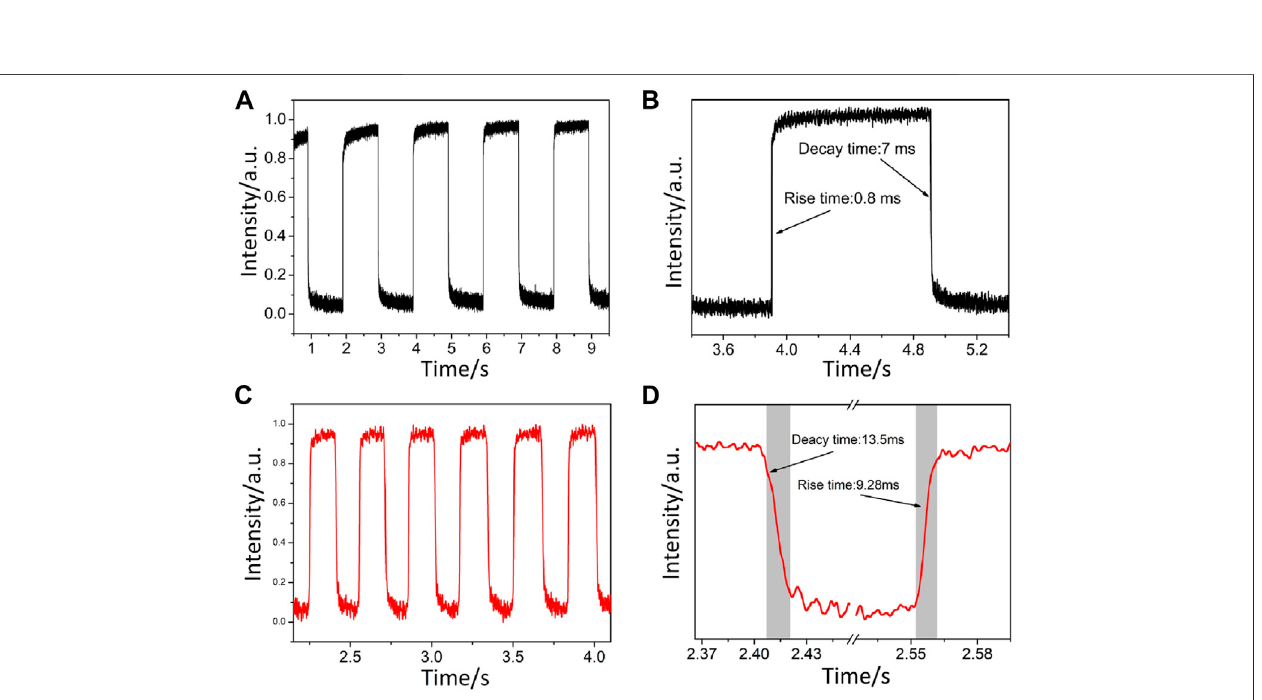
Frontiers in Materials |